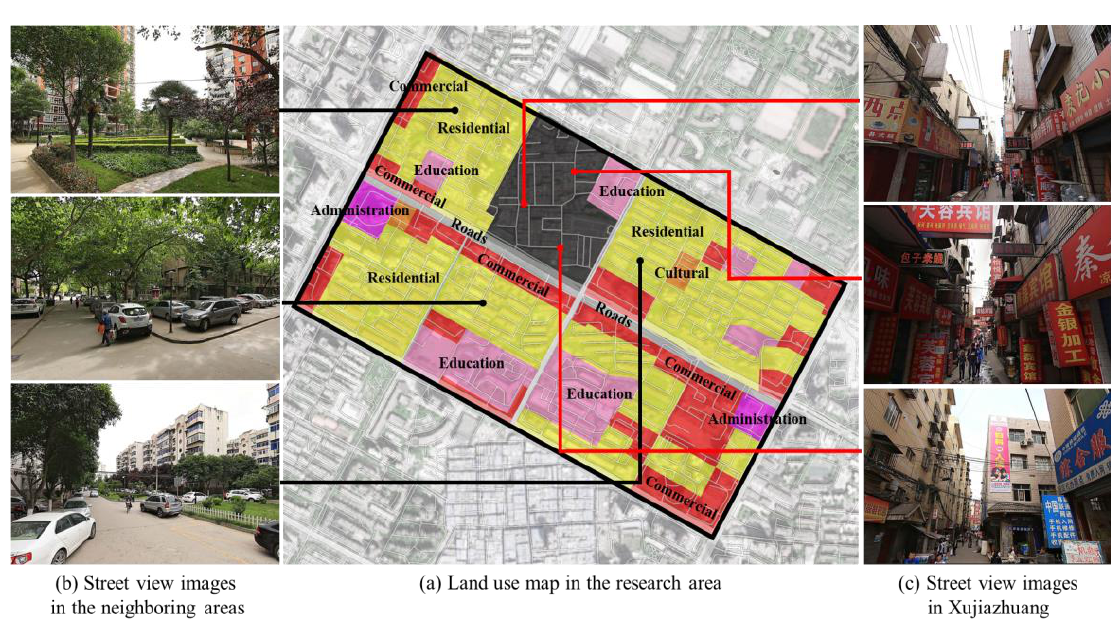
Figure 2. Street view images of the research area and its neighboring blocks in Xi’an.